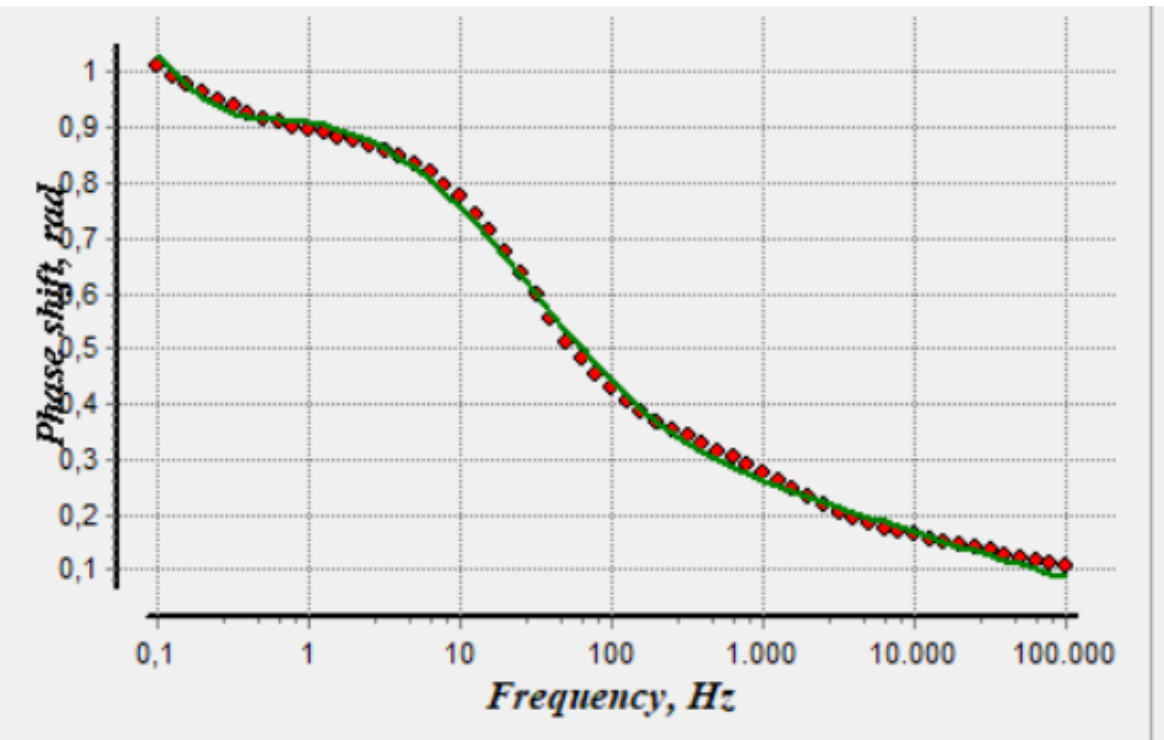
Figure 3S: Fitted impedance spectrum and the equivalent electric circuit of the electrochemical cell with Saccharomyces cerevisiae as biorecognition